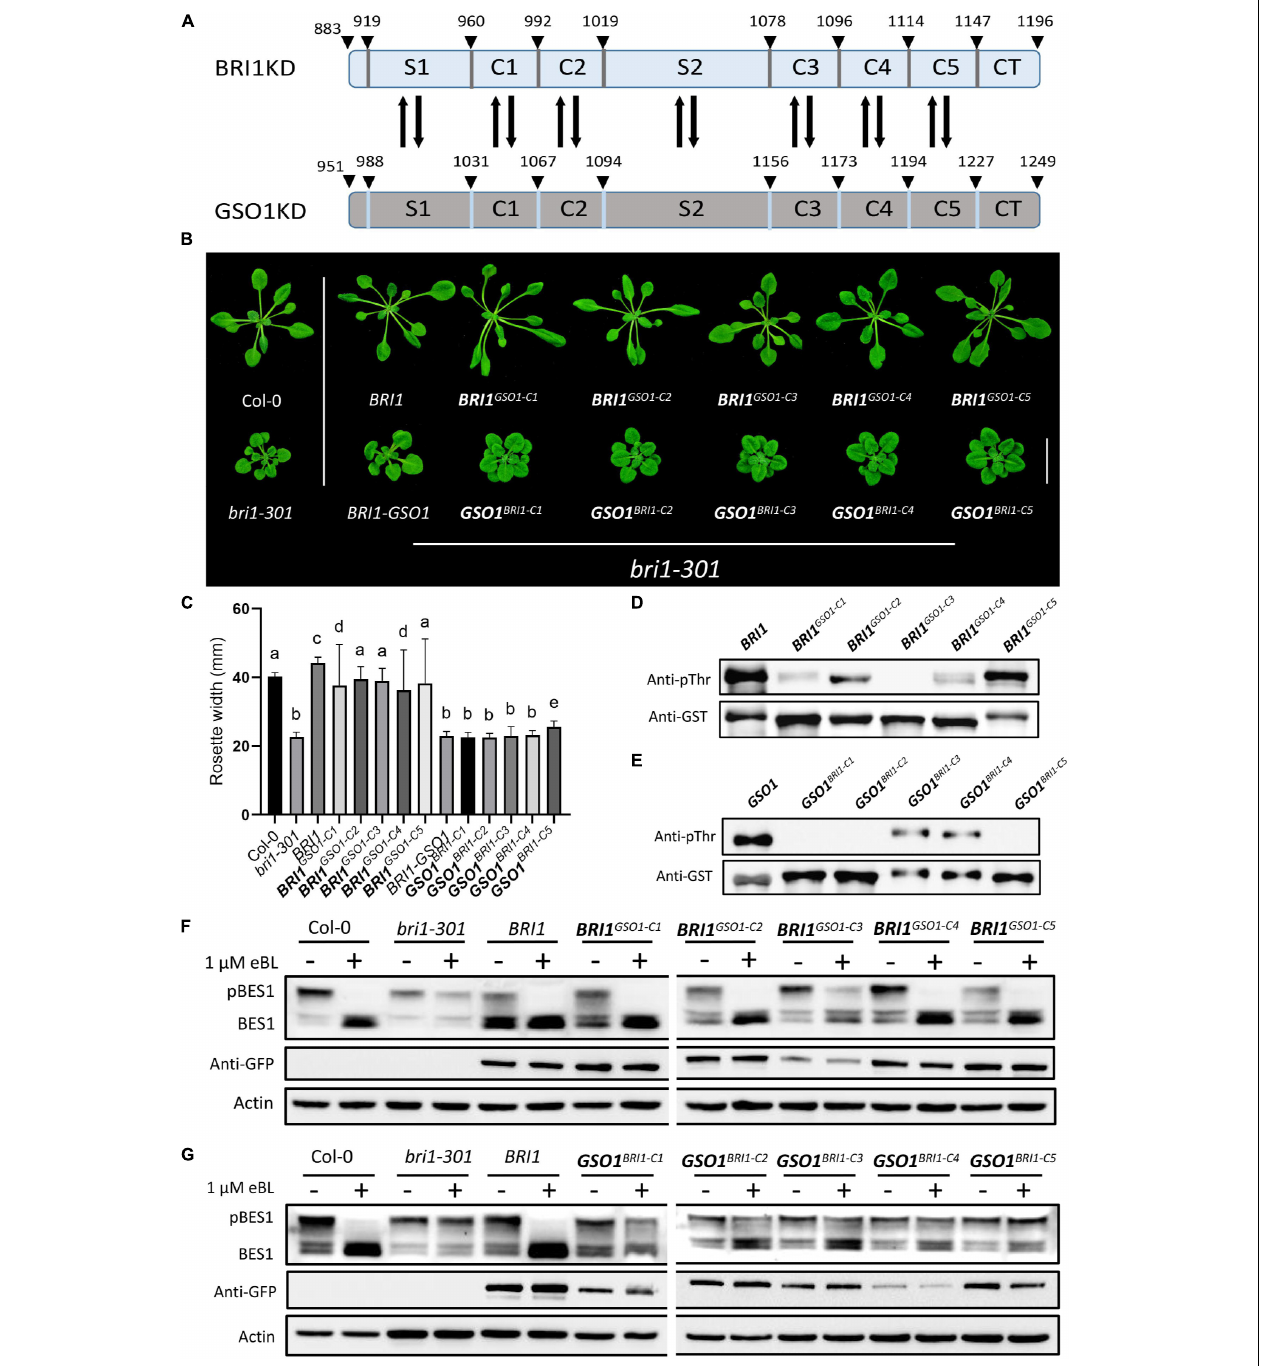
FIGURE 2 | The C motifs are functionally conserved in biology but diverse in kinase activity. (A) Schematics of BRI1 and GSO1 KDs motifs showing the positions for domain swap. The number above represents the positions of amino acids residues on KDs. (B) Phenotypic analysis of wild type, bri1-301, and transgenic lines expressing chimeric receptors. Biologically functional conservation for the C domain of BRI1 during evolution. Scale bar = 2.0 cm. (C) Rosette width comparison of lines shown in panel (B) ( n = 15), p < 0.0001, one-way ANOVA with Tukey’s test. Different letters indicate significant differences. (D,E) Phosphorylation activity of GST-fused with the KDs of BRI1 and BRI1 GSO 1 − C chimeras, GSO1 and GSO1 BRI 1 − C chimeras. The anti-pThr antibody was used to detect the autophosphorylation levels. GST-tagged proteins detected by anti-GST antibody served as a loading control. All the experiments were repeated independently three times with similar results. (F,G) Immunoblotting of eBL induced dephosphorylation of wild type, bri1-301 , BRI1 and transgenic lines of BRI1 GSO 1 − C 1 BRI1 GSO 1 − C 2 BRI1 GSO 1 − C 3 BRI1 GSO 1 − C 4 BRI1 GSO 1 − C 5 and GSO1 BRI 1 − C 1 GSO1 BRI 1 − C 2 GSO1 BRI 1 − C 3 GSO1 BRI 1 − C 4 GSO1 BRI 1 − C 5 . An anti-GFP antibody was used to quantify the protein expression. Actin served as a loading